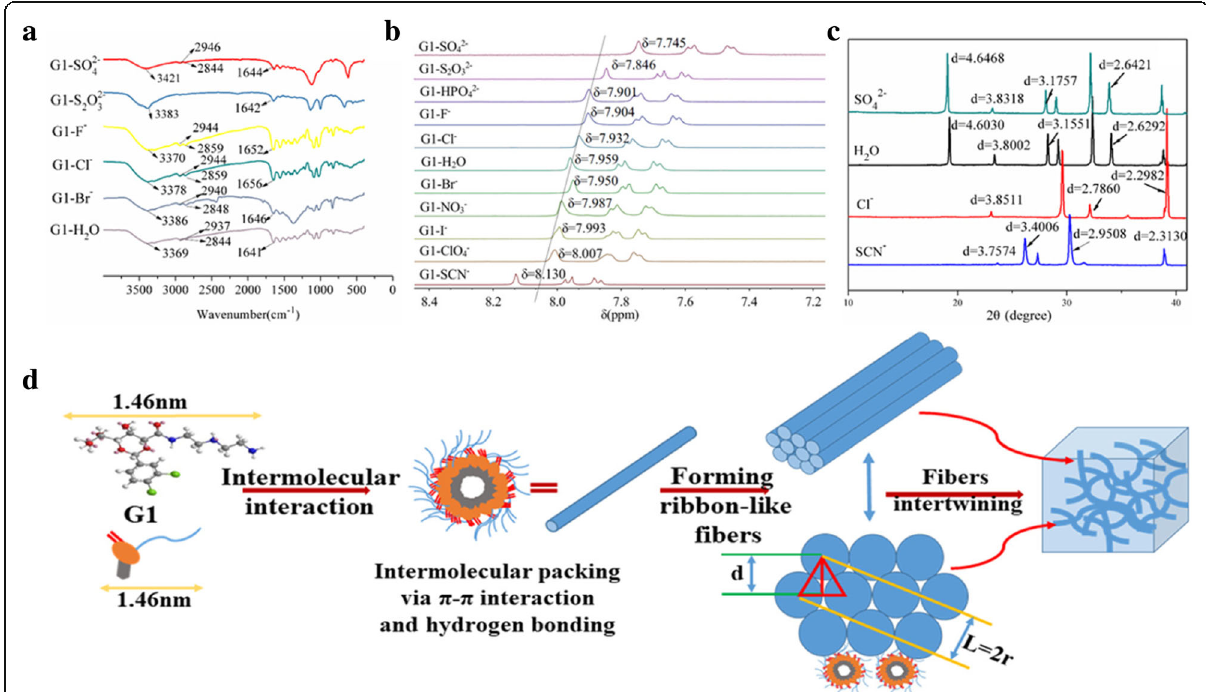
Fig. 4 a FT-IR spectra of G1 xerogel (2.5% w / v ) in the presence of some kosmotropes ions (concentration is 0.5 M). b 1 H NMR spectra of G1 (2.5% w / v ) in